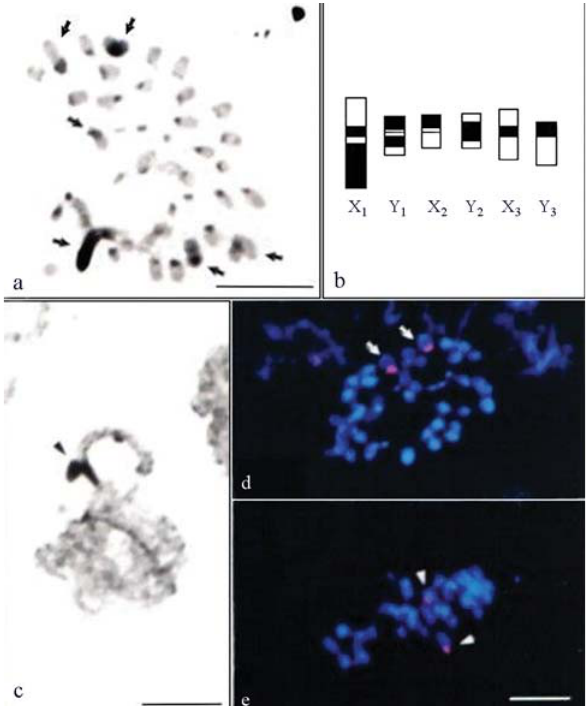
Figure 3 - C-banding pattern, AgNO 3 staining and fluorescent in situ hy- bridization with a ribosomal probe of meiotic and mitotic chromosomes of Euchromagigantea .(a)Mitoticmetaphaseofamale.(b)Schematicrepre- sentationoftheC-bandingpatternofthesexchromosomes.Thearrowsin- dicate the sex chromosomes. (c) Zygotene. The arrowhead indicates the AgNO 3 -stainednucleolarorganizerregion.(d)Spermatogonialmetaphase showing the two rDNA sites. (e) Metaphase I indicating the location of the sites on the X 1 and X 2 chromosomes (arrowheads). Bar = 10 μ